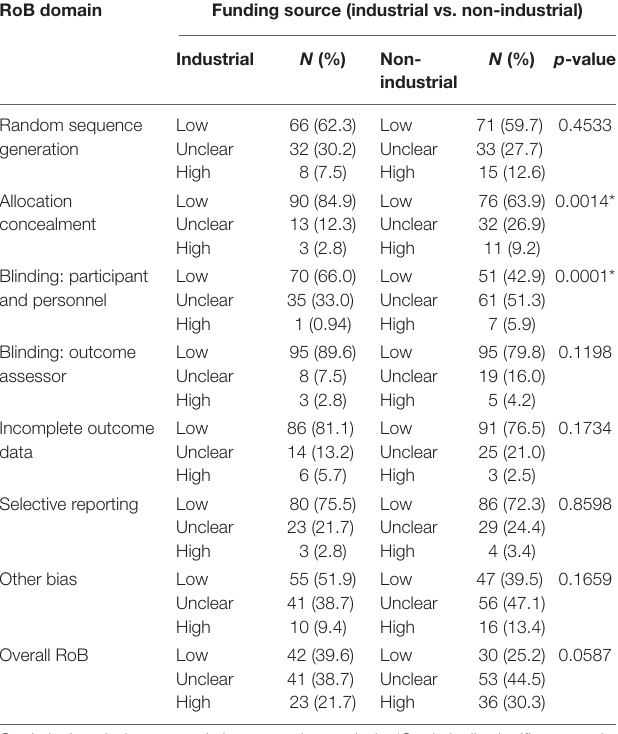
TABLE 4 | Risk of bias assessments by domain in studies funded by the industry or non-industry ( N = 250). RoB